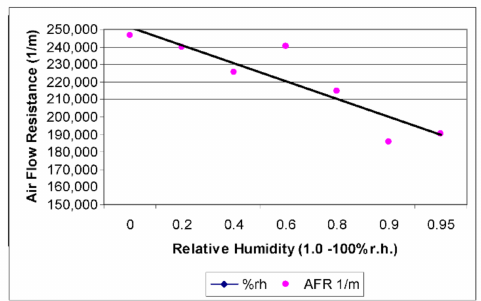
Figure 9. Active yarn textile prototype test results. Textile reduces resistance to airflow as humidity increases correlation coe ffi cient r = − 0.86.